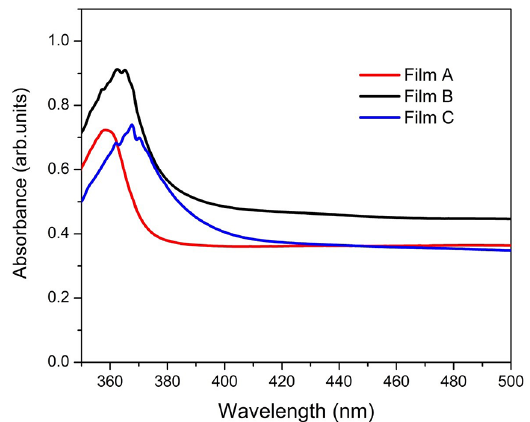
Figure 5. Normalized Absorbance plots for the three ZnO films Band gap energy (Eg) was calculated for the three thin films A, B and C. The Tauc equation used to estimate the Eg values was described by Tauc (1974) 25 : (4) Where, A is proportionality constant, hv the incident photon energy and α is the absorption coefficient. The value of ½ is applied due to the direct transition characteristic of the ZnO material. The Eg value was obtained by the extrapolation of the plot of ( αhv ) 2 as function of the incident energy hv (Fig. 6) 26 . The band gap values were between 3.05 and 3.32 eV, as described in table 1. All the Eg values were below the standard 3.37 eV report in the literature 27 . The lowest potential applied in the ECD deposited the film with the highest band gap energy, while the minimum value for the band gap was obtained for the sample C. As the energy bad gap values decrease, there is a shift in